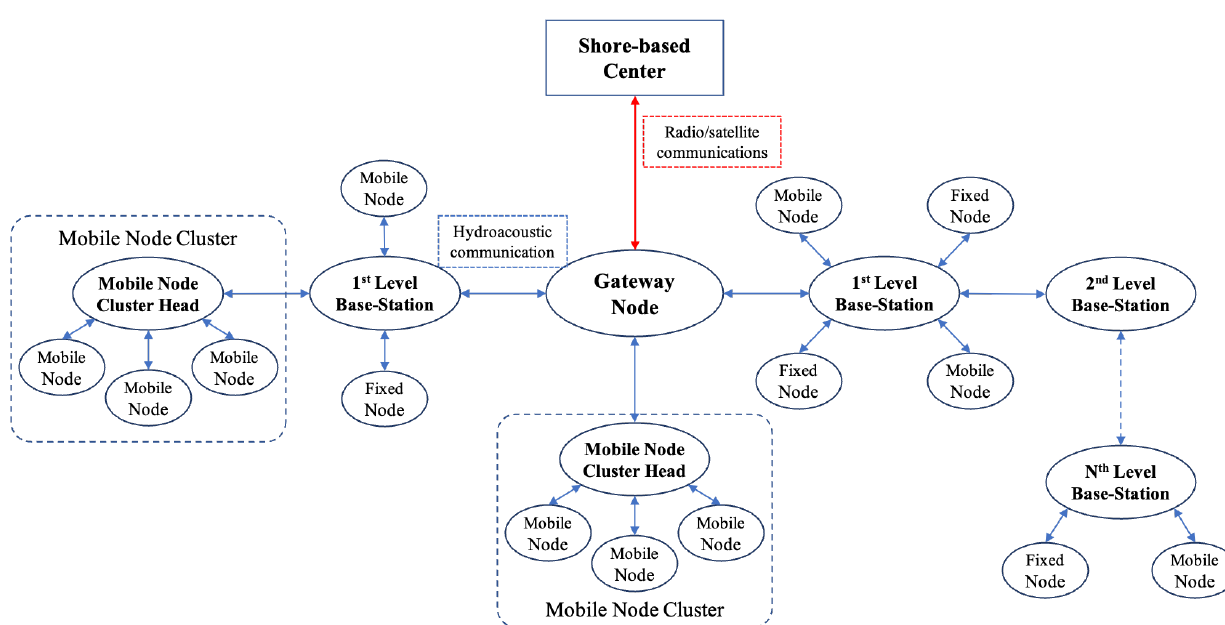
Figure 2. Topology of uw -Cellular